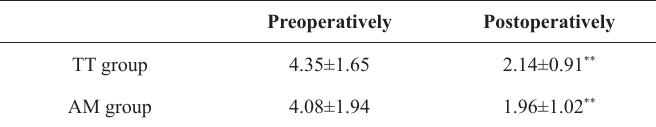
TABLE 2 - KT-1000 anterior laxity of knee joint at 30°C flexion after ACL reconstruction in both groups